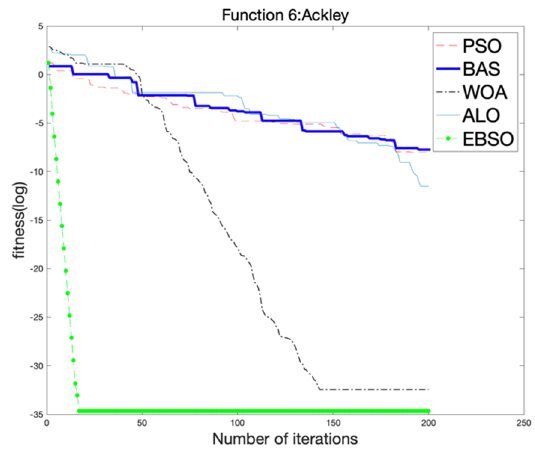
Figure 11. Iterative convergence graph.